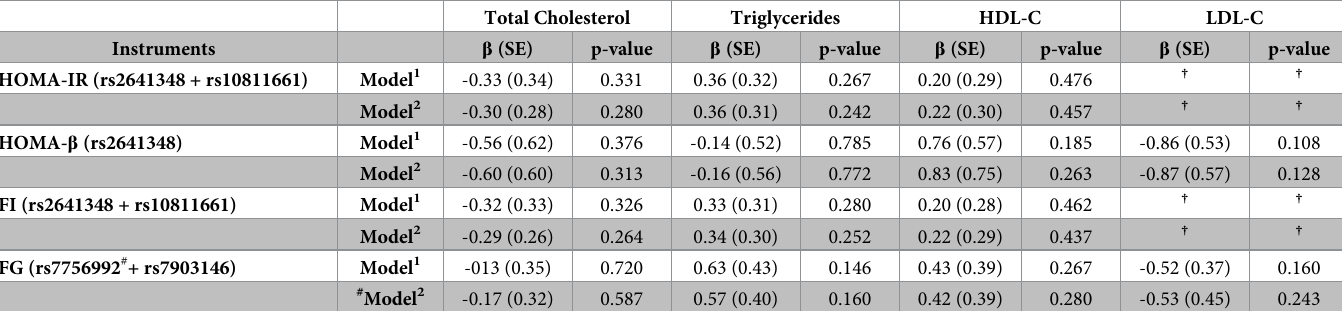
Table 3. Association of glycemic traits (explained by instruments) with lipids: Mendelian Randomization